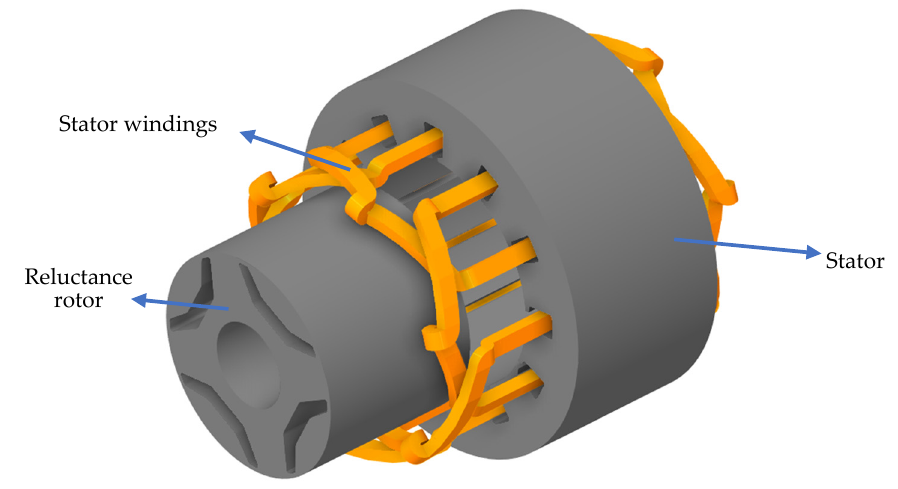
Figure 1. Three-dimensional sketch of a one-barrier four-pole synchronous reluctance motor.